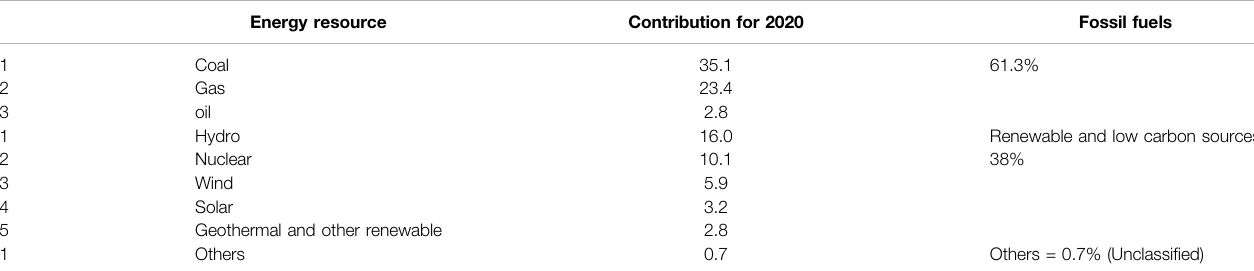
TABLE 3 | The global electricity generation can be summarized in Table 3 below. Energy resource